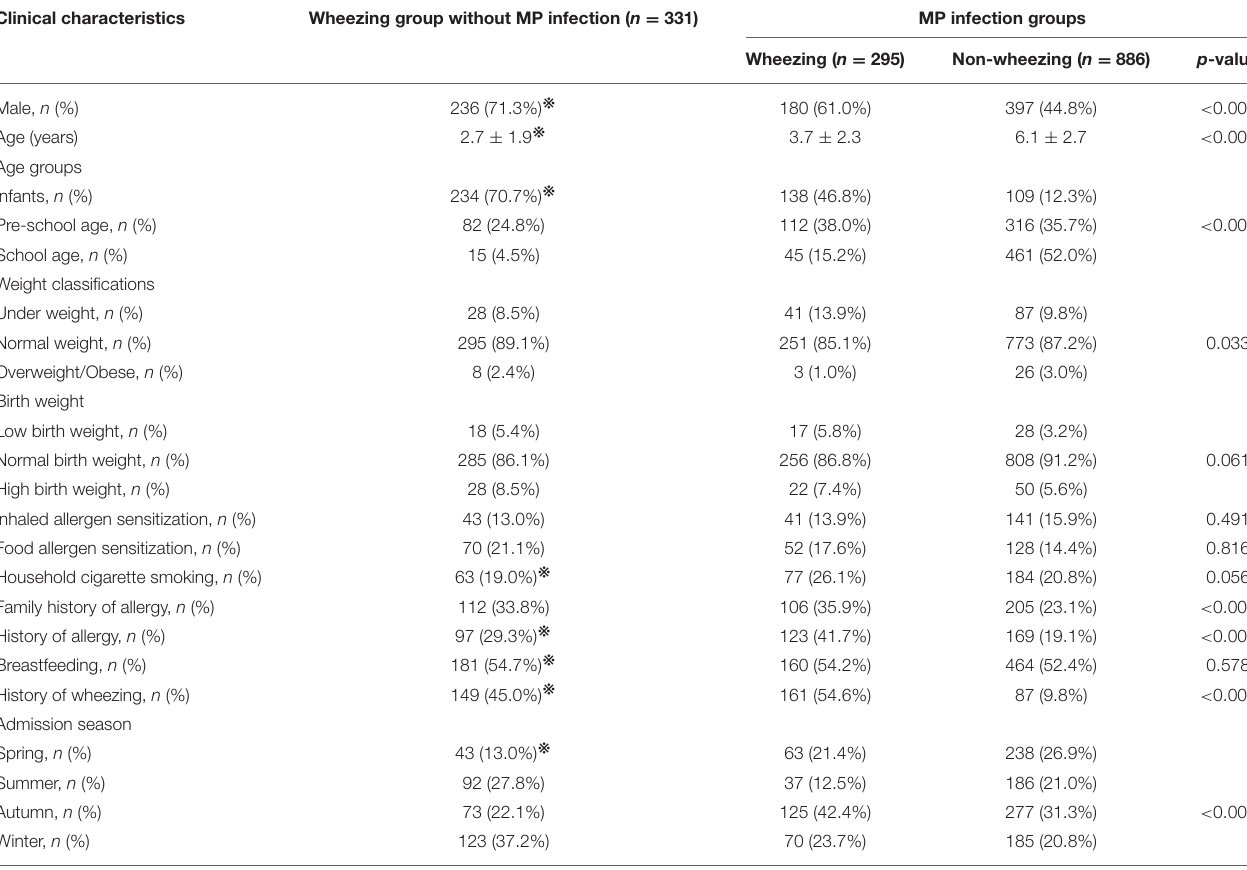
TABLE 1 | Clinical characteristic of all included patients with and without MP